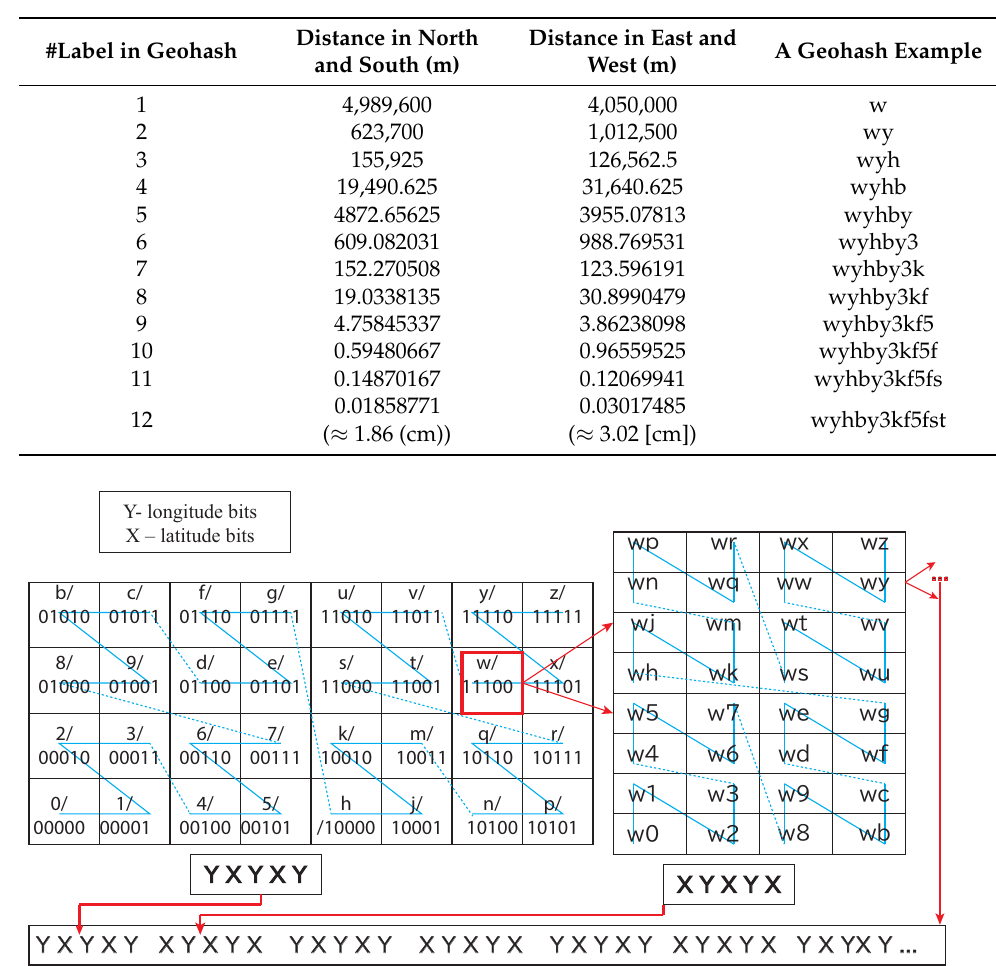
Table 1. Geographical size of Geohash encoding.